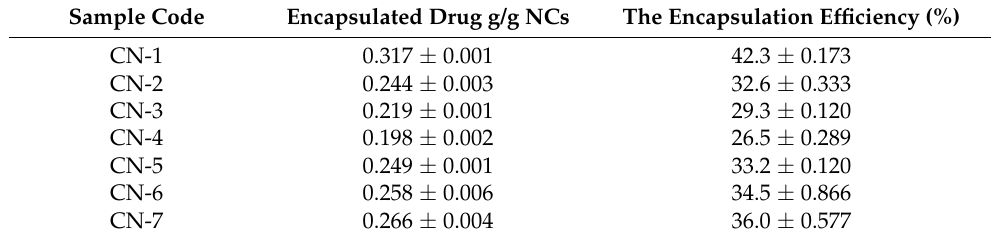
Table 4. Drug encapsulation efficiency values.